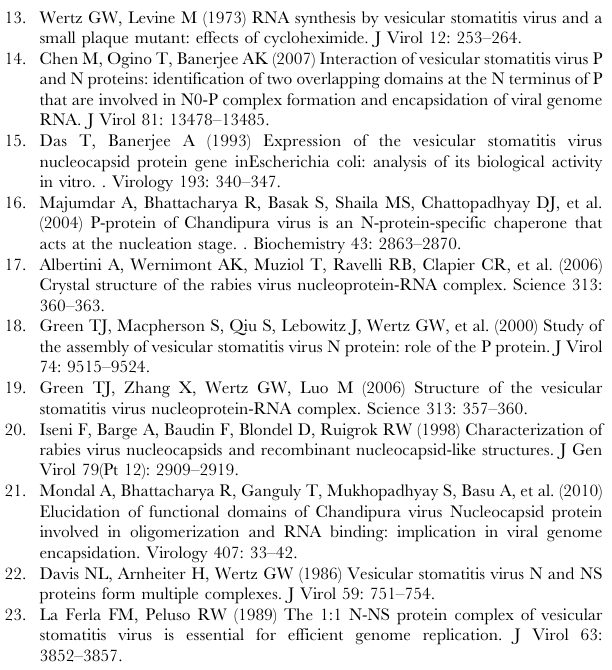
Figure S1 CHPV P proteins acts as an N-specific chaperone when transfected at a 1:1 ratio in Vero-76 cell lines. Upon transfection of Vero-76 cells with GFP-N and P encoding constructs in a 1:1 ratio, about 90% cells exhibited homogenization of the otherwise punctated distribution of